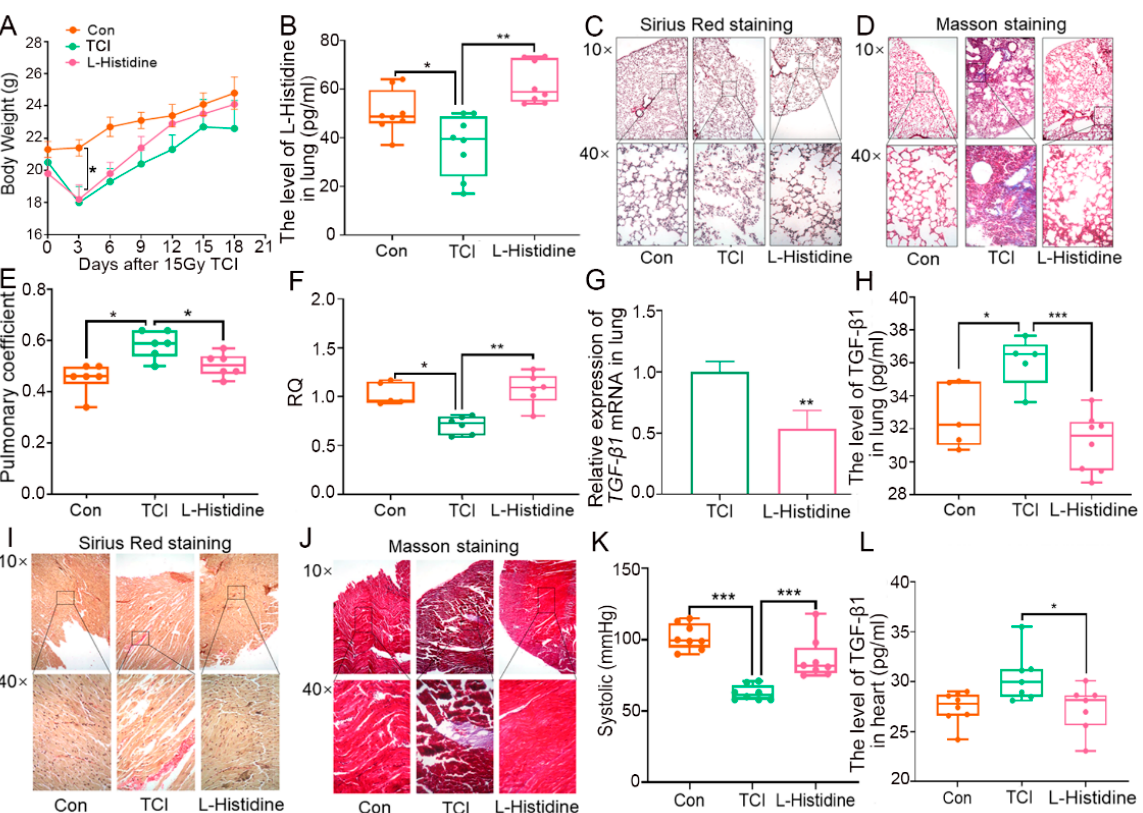
Figure 1. Gut microbiota-derived L -Histidine improves radiation toxicity in lungs and heart. ( A ) Body weight of mice after 15 Gy TCI and L -Histidine treated group after TCI. ( B ) The L -Histidine expression in lung tissues by ELISA ( n = 8). ( C , D ) The lung tissues of each group mice were stained with Sirius Red ( C ) and Masson ( D ) and were observed under 10 × and 40 × microscopes, respectively. ( E ) Determination of the pulmonary coefficient in each group of mice ( n = 6). ( F ) RQ of mice in each group of mice in 24 h ( n = 6). ( G , H ) The TGF- β 1 levels in lung tissues of each group mice were assessed by q-PCR and ELISA ( n = 6). ( I , J ) The heart tissues of each group mice were stained with Sirius Red ( I ) and Masson ( J ) and were observed under 10 × and 40 × microscopes, respectively. ( K ) The systolic of each group of mice ( n = 8). ( L ) The TGF- β 1 levels in the heart tissues of each group mice were assessed by ELISA ( n = 7). (The data are presented as mean ± SD, * p < 0.05, ** p < 0.01 and *** p < 0.001; Student’s t -test.).